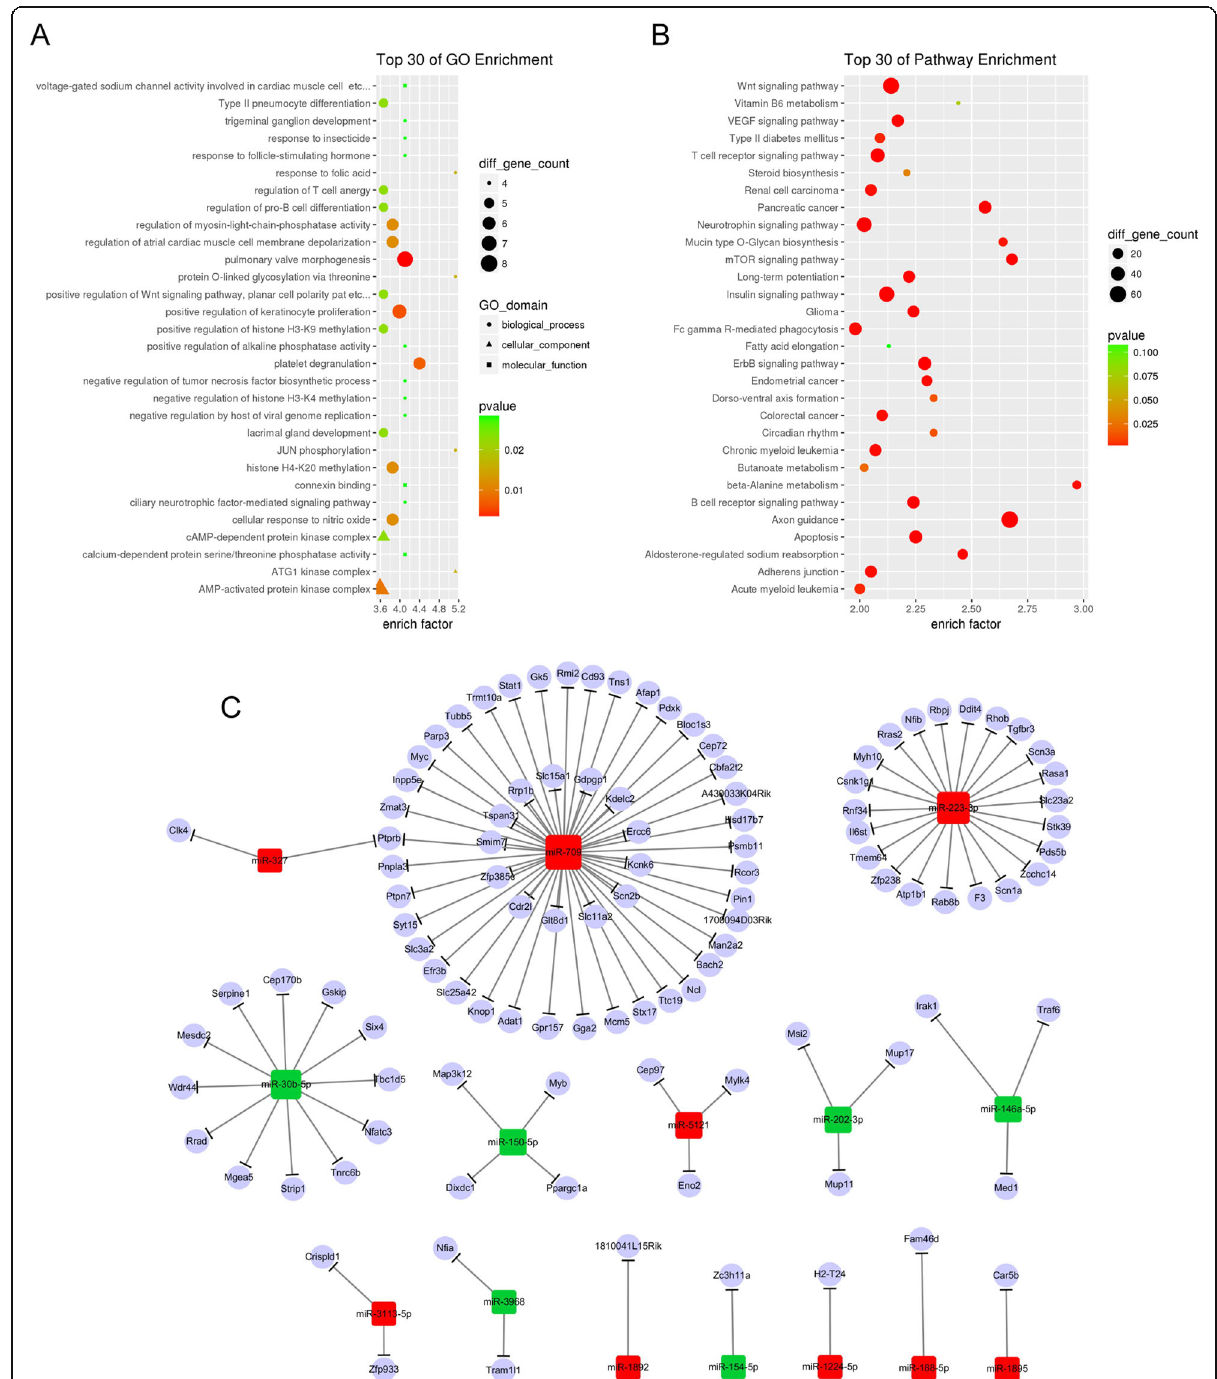
Fig. 3 Bioinformatics analysis of the differentially expressed microRNAs. a - b Gene Ontology (GO) and Kyoto Encyclopedia of Genes and Genomes (KEGG) pathway analysis of target genes. c Schematic illustration of potential microRNAs target